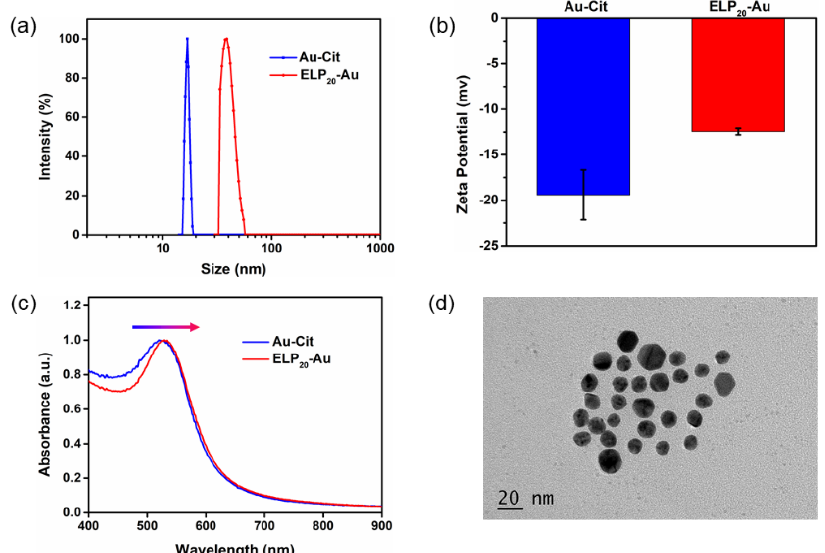
Figure 2. Characterizations of synthesized Au - Cit and (ELP) 20 - Au NSs. ( a ) Hydrodynamic diameter distribution ( b ) Zeta potential ( c ) UV-Vis spectra of Au-Cit and (ELP) 20 -Au NSs. ( d ) Transmission electron microscopy image of (ELP) 20 -Au NSs.